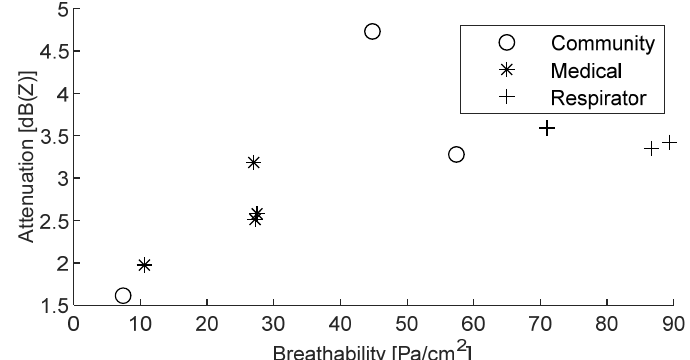
Figure 16. Acoustic attenuation versus breathability.